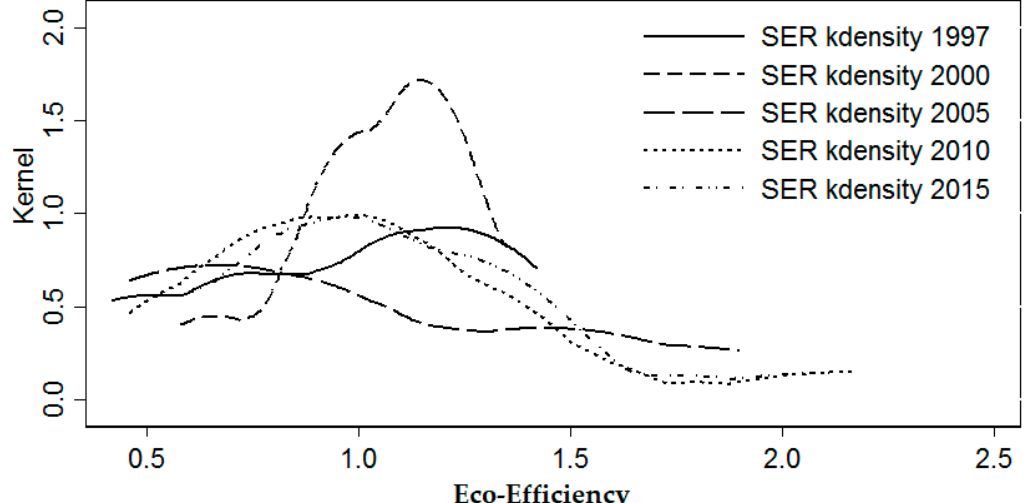
Figure 6. Kernel Density Estimation on the Eco-efficiency of Industrial Energy along the Yangtze River Economic Belt.